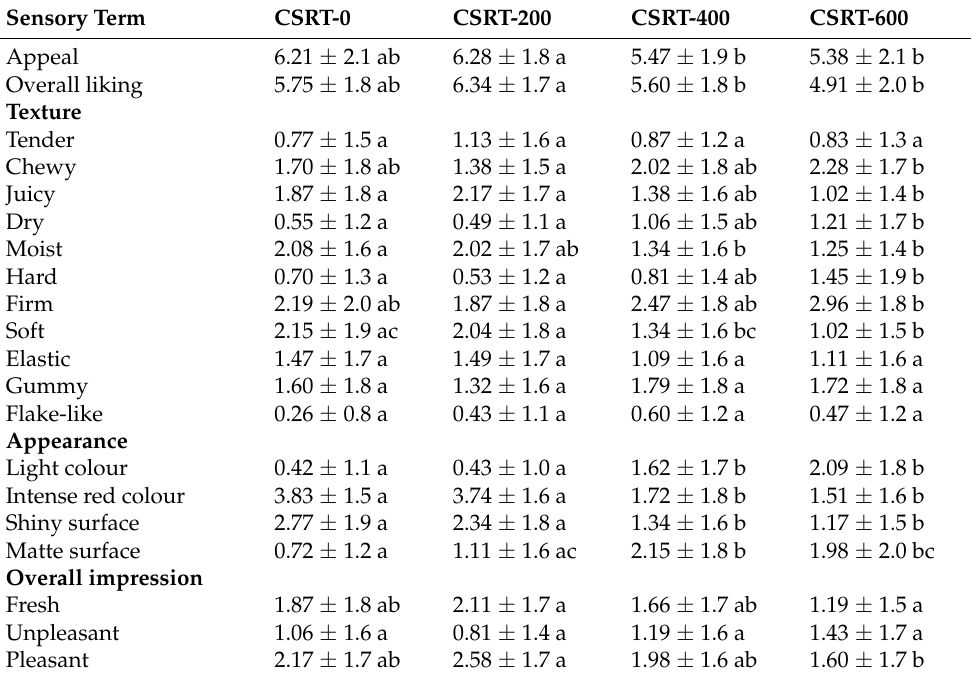
Table 2. The appeal (1 = not appealing at all, 9 = very appealing), overall liking (1 = I do not like it at all, 9 = I like it very much) and Rate-All-That-Apply (1 = slightly applicable, 5 = very applicable) results (average ± standard deviation) of cold smoked rainbow trout (CSRT) samples obtained with consumer sensory evaluation (n = 53).